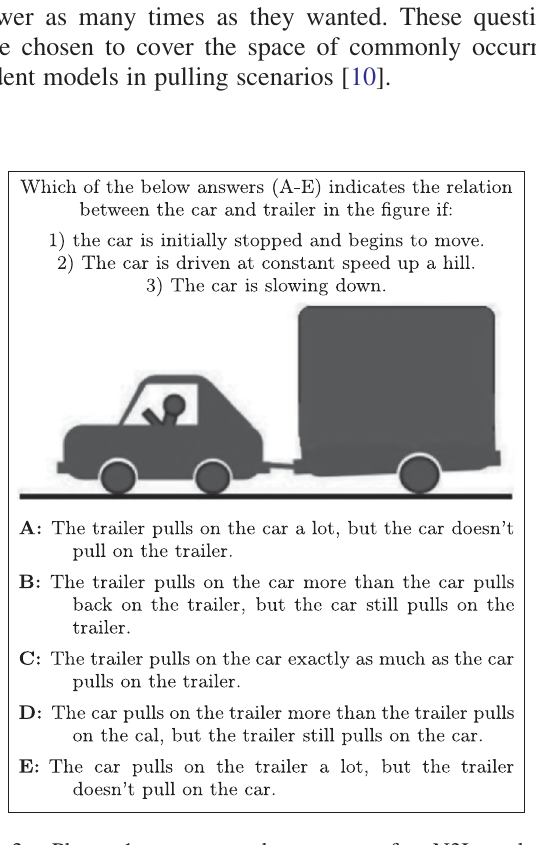
FIG. 3. Phase 1 prompt and responses for N3L task for Mechanics. The students were asked to consider situations where the car was speeding up, constant speed up a hill, constant speed on a level road, and slowing down. In each case, the force that the car exerts on the trailer is equal and opposite to the force that the trailer exerts on the car.